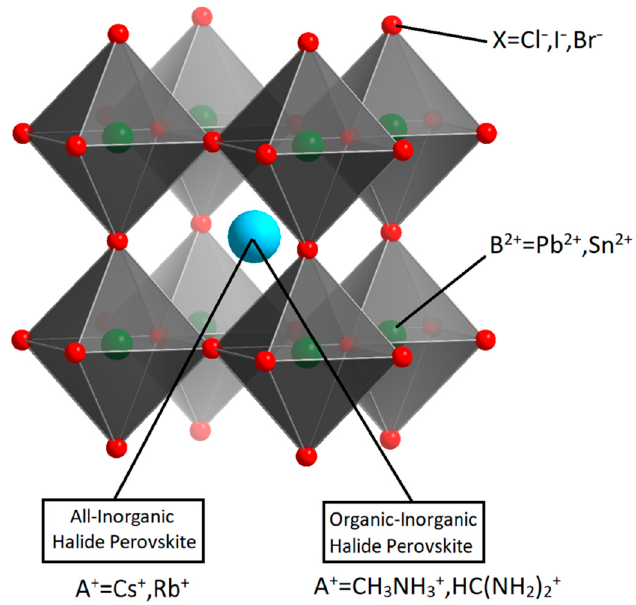
Figure 1. Schematic diagram of ABX 3 lead halide perovskite crystal structure. R B , R X represents the ion radius of the corresponding ion. When µ is between 0.4 and 0.9, it helps to form a stable BX 6 octahedron. The BX 6 octahedron also undergoes